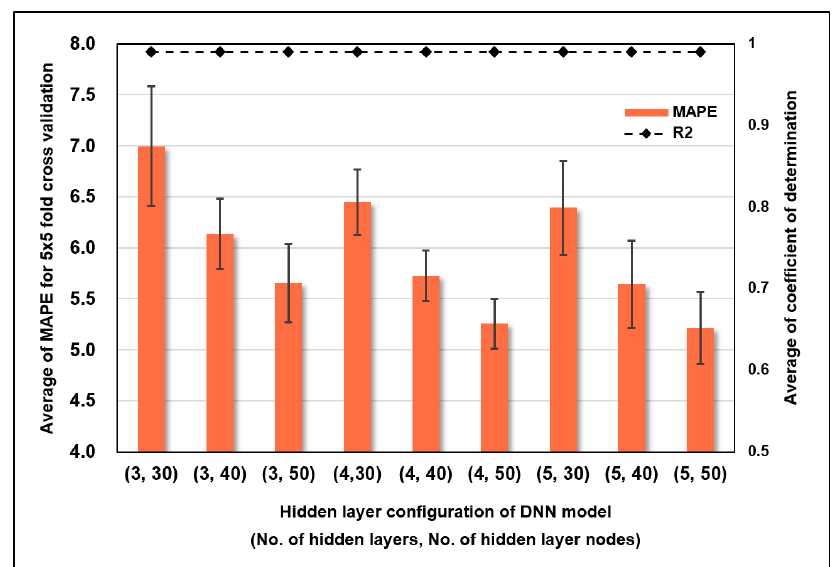
Figure 10. Results of 5 × 5-fold cross validation for predicting ore production during afternoon.